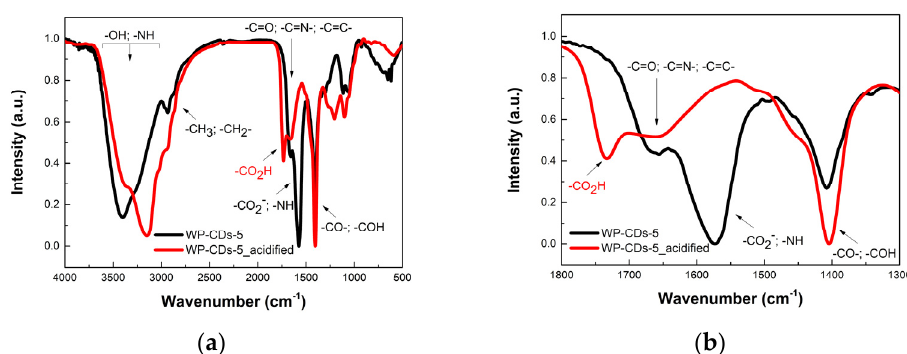
Figure 1. ( a ) FTIR spectrum of WP-CDs-5 (black line) synthesized using a [P-2] = 0.16 g/mL, an EDA/P-2 mass ratio = 0.08, at 250 °C during 72 h, overlayed with that of WP-CDs-5 obtained after acidification (red line; see text). ( b ) The same spectra amplified in the region between 1800–1300 cm − 1 .